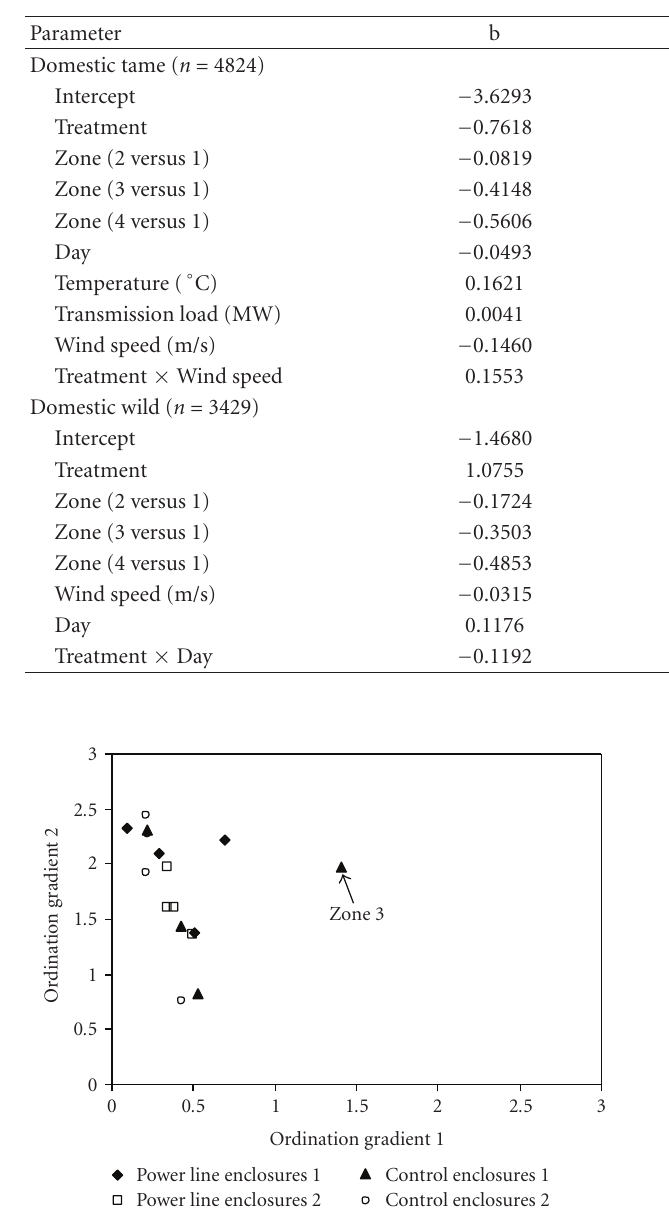
Table 2: Results from the best mixed logistic regression model of proportion restless behaviour of two trials with 12 domestic reindeer each. Animals of di ff erent degree of tameness were tested separately. Intercept in all models is the estimate for zone 1 in a control enclosure. The model uses a logit-link.